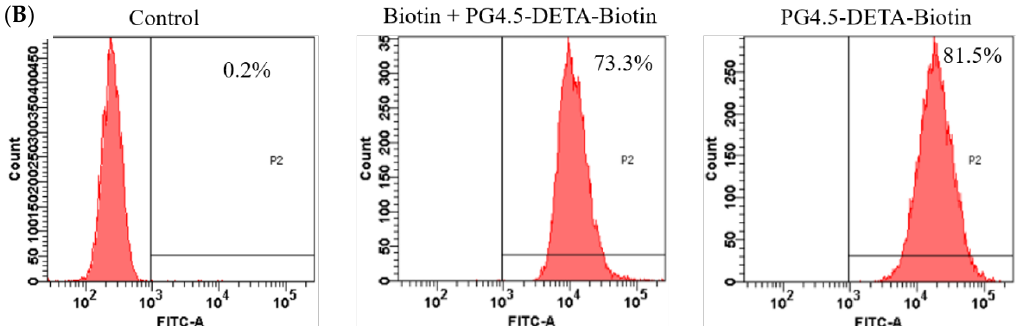
Figure 5. ( A ) Fluorescent microscopic images of HeLa cells treated with biotin + PG4.5-DETA-biotin and PG4.5-DETA-biotin for 2 h or 6 h (scale bar = 20 µm). ( B ) Flow cytometry analysis of the cellular uptake efficiency in HeLa cells treated with PBS as control, biotin + PG4.5-DETA-biotin/GEM and PG4.5-DETA-biotin/GEM for 6 h.